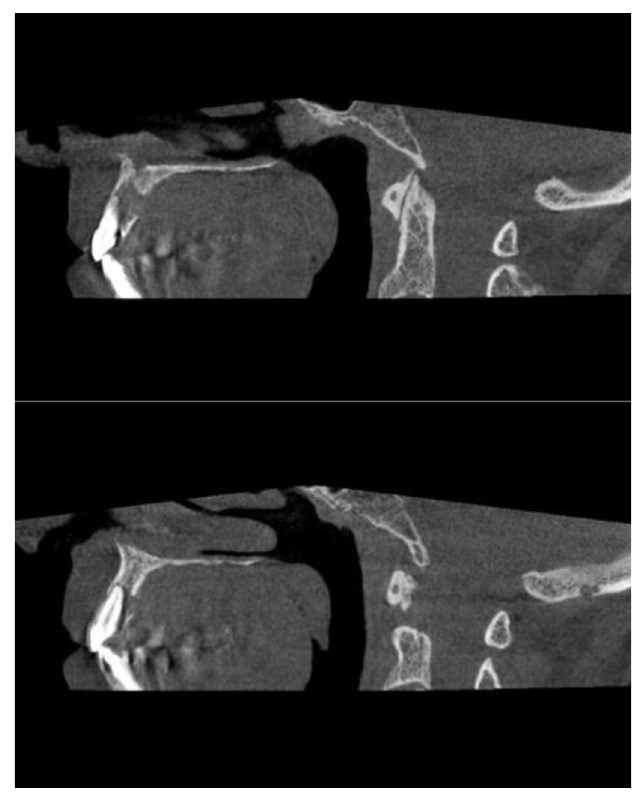
Fig. 3. Computer tomographic views in sagittal section showing the osteonecrosis.